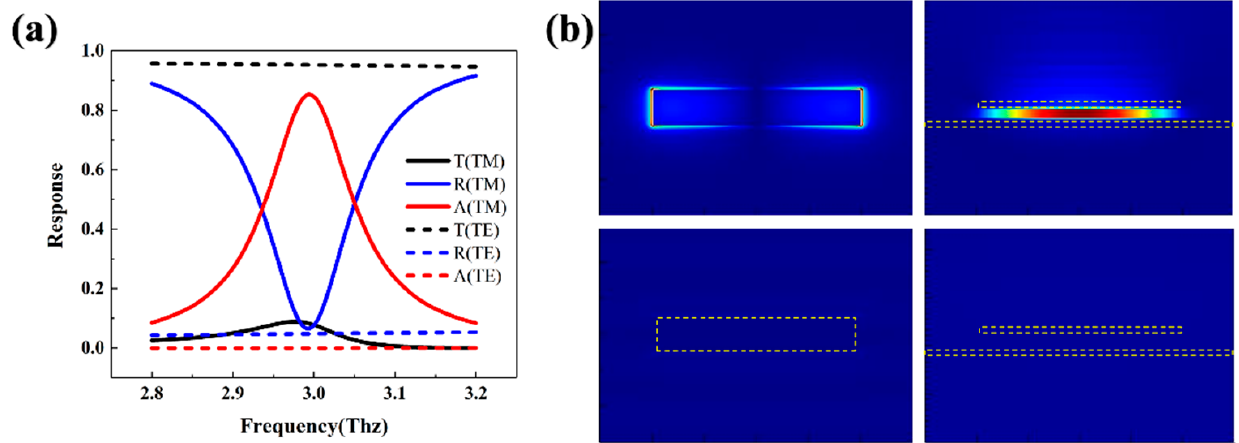
Figure 6. ( a ) Response spectrum (absorption, reflectivity, and transmission) of TM and TE polarized